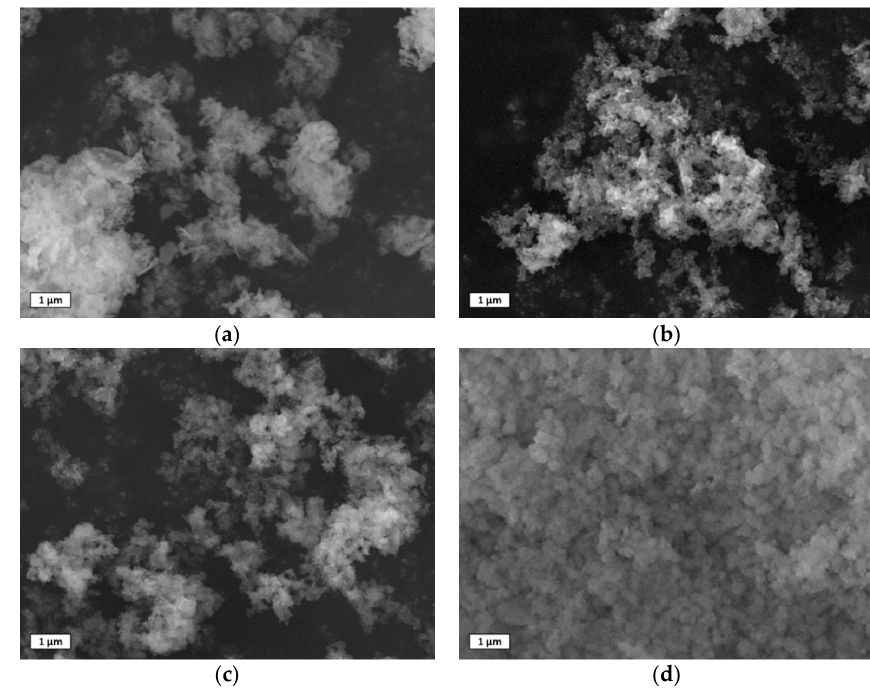
Figure 3. Scanning electron microscopy (SEM) images using secondary electron of as–prepared samples: